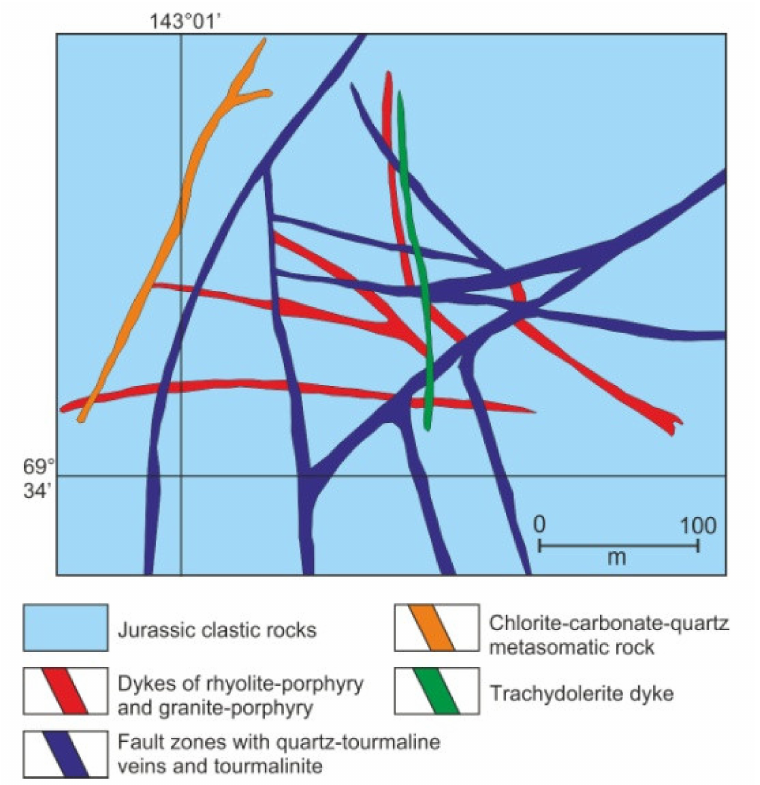
Figure 15. Field geological map of the south-eastern part of the Istekh ore field (compiled by V.A. Trunilina). See Figure 4 for